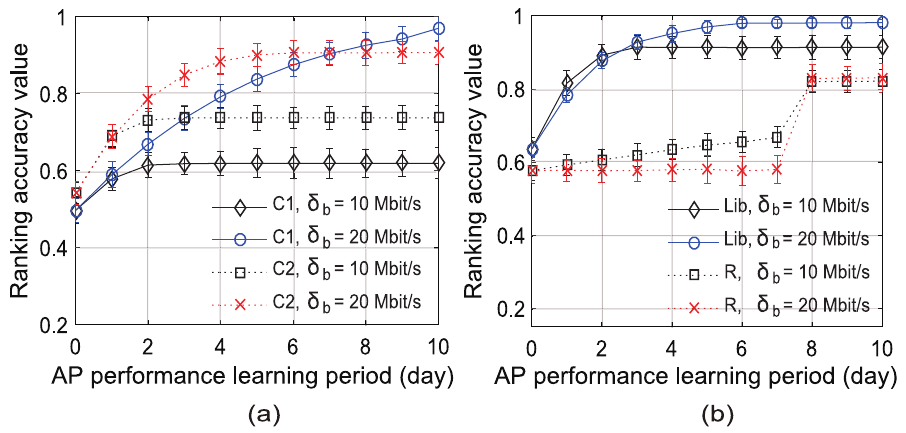
Fig 14. Ranking accuracy results of our UAAS scheme versus the period for AP performance learning in Scenario 2. (a) at C1 and C2, (b) at Lib and R.